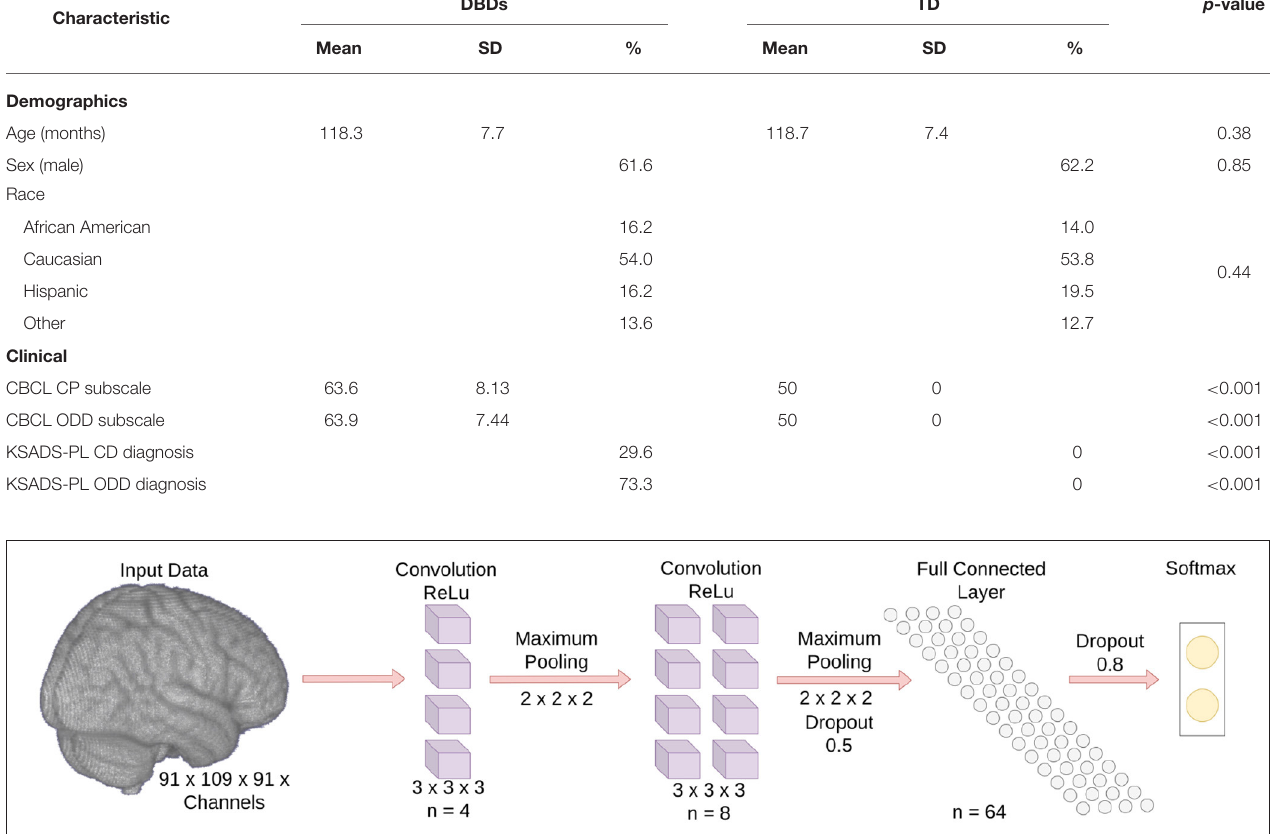
FIGURE 1 | Schematic of the 3D CNN model. The number of input data channels is not shown because it varies depending on the input